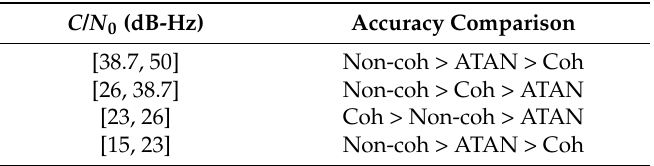
Figure 14. The standard deviation (STD) values of estimation error of carrier phase error in different C / N 0 . Table 5. Accuracy comparison of carrier phase error estimation.